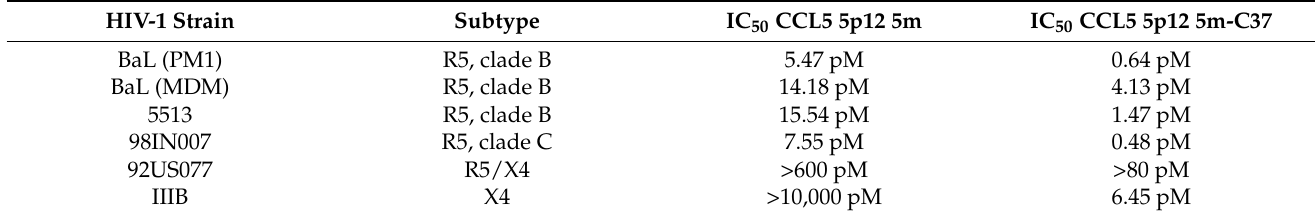
Table 1. Anti-HIV-1